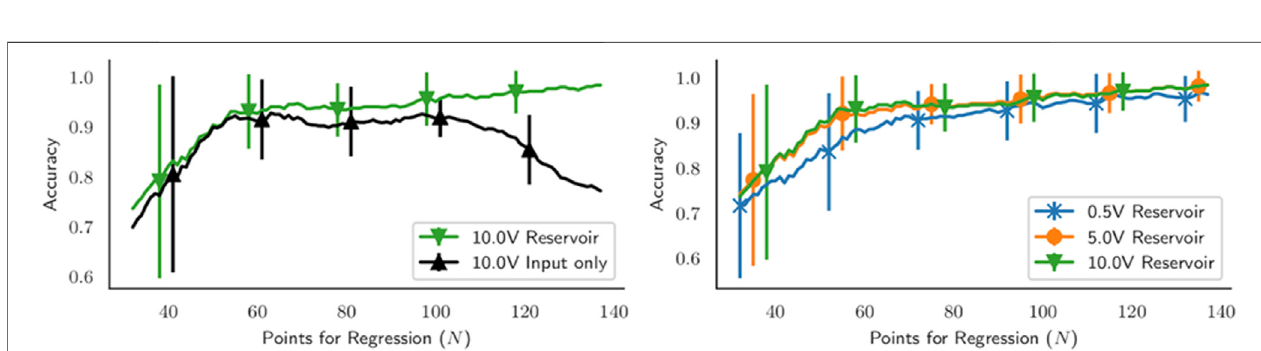
FIGURE 7 | (Left) Performance of the spoken digit classi fi cation task using AgI nanowire networks for in-materio RC to tap the temporal sequence of spoken digit MFCCs at N different points and regressing to identify the digit spoken. Mean accuracy and standard deviation clearly shows that the “ Reservoir ” readout method avoided over fi tting and improved task performance as compared to using the “ Input Only ” mode (Right) . The input signal amplitude (voltage) was observed to have minimal. impact on accuracy, indicating the potential for maintaining task performance under low-power operation of AgI ASNs.